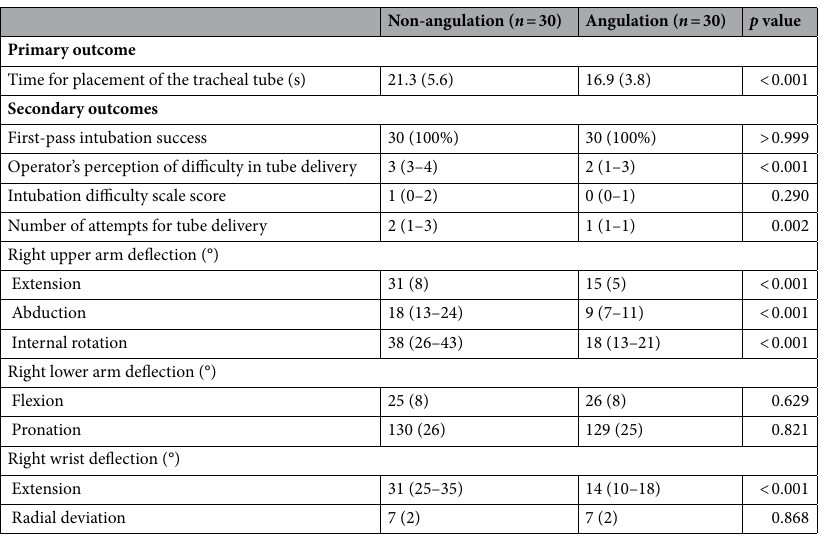
Table 2. Primary and secondary outcomes. Data are expressed as mean (standard deviation), number (proportion), or median (interquartile